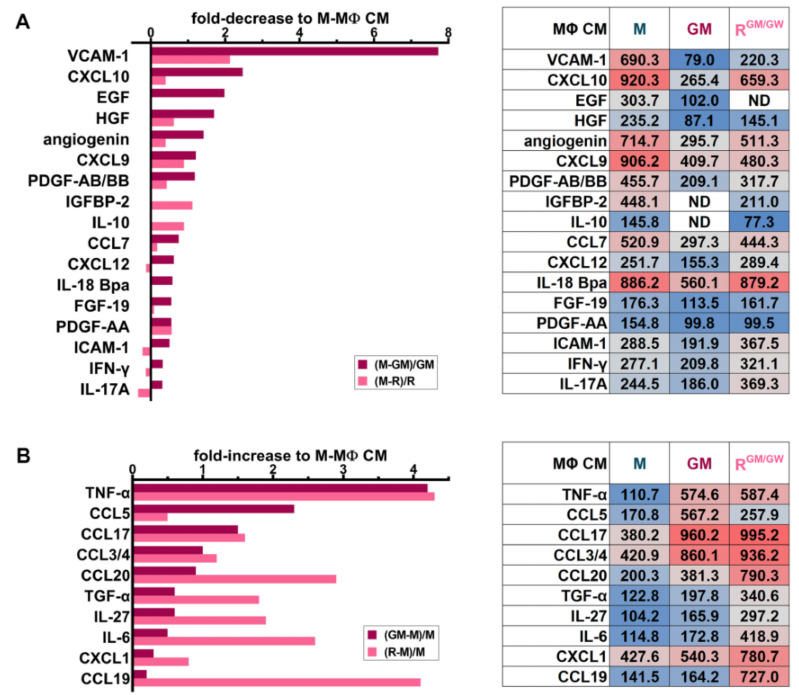
Figure 7. Cytokine secretion profiles differ with M Φ polarization status. HD monocytes were stimulated for 7 days with M- or GM-CSF and CM was collected and analyzed. Alternatively, CM of M Φ s whose culture medium has been supplemented with M-CSF for 1 week and switched to reorienting medium supplemented with GM-CSF (GM) and GW2580 (GW) for one more week was also collected. ( A ) A selection of cytokines is illustrated, which are decreased in GM- (dark red) and R-M Φ (pink) CM compared to M-M Φ CM, according to the formula in graph legend. ( B ) Selected increased cytokines in GM- (dark red) or R-M Φ (pink) CM compared to M-M Φ CM are illustrated and calculated according to the formula in the graph legend. For both A and B, the relative optical density of the selected cytokines are indicated in the tables and colored from blue (low) to grey (medium) to red (high) according to their mean pixel